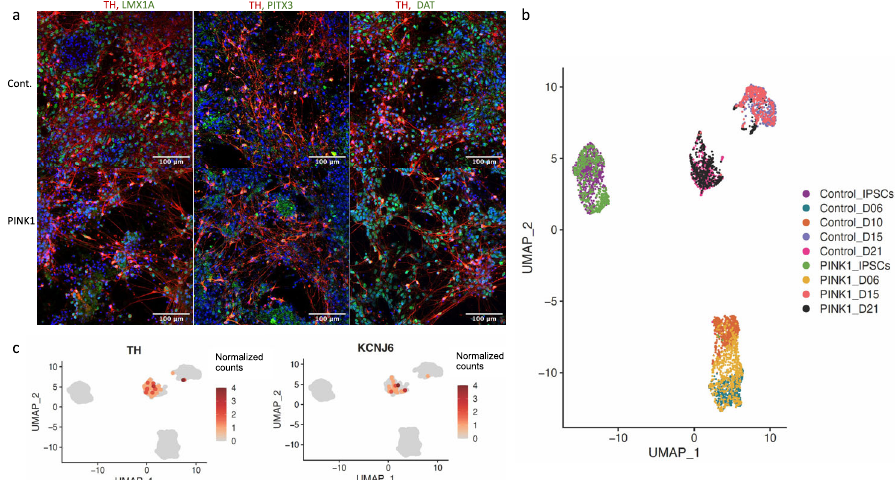
Fig. 4 Classi fi cation of mDA status. a TH positive neurons co-express mDA markers PITX3, LMX1A, and DAT in control (top) and PINK1 cell line (bottom), at D35. For images of individual targets see Supplementary Fig. 13 and for colorblind-friendly images see Supplementary Fig. 14. b Based on our SC-RNAseq data, cell lines cluster according to differentiation stage, indicating that gene expression is very homogenous between the control and the PINK1 -ILE368ASN cell lines, which allows for the detection of even subtle alteration induced the presence of the PINK1 mutation. c Trajectory of expression of TH and KCNJ6 ( GIRK2 ), two mDA neuron markers. At D21 neurons begin to show TH expression, together with an expression of other mDA markers, which indicates that they are becoming early postmitotic mDA neurons 25 . Similar observations can also be made from an expression heatmap shown in Supplementary Fig. 12. The scale represents normalized counts.